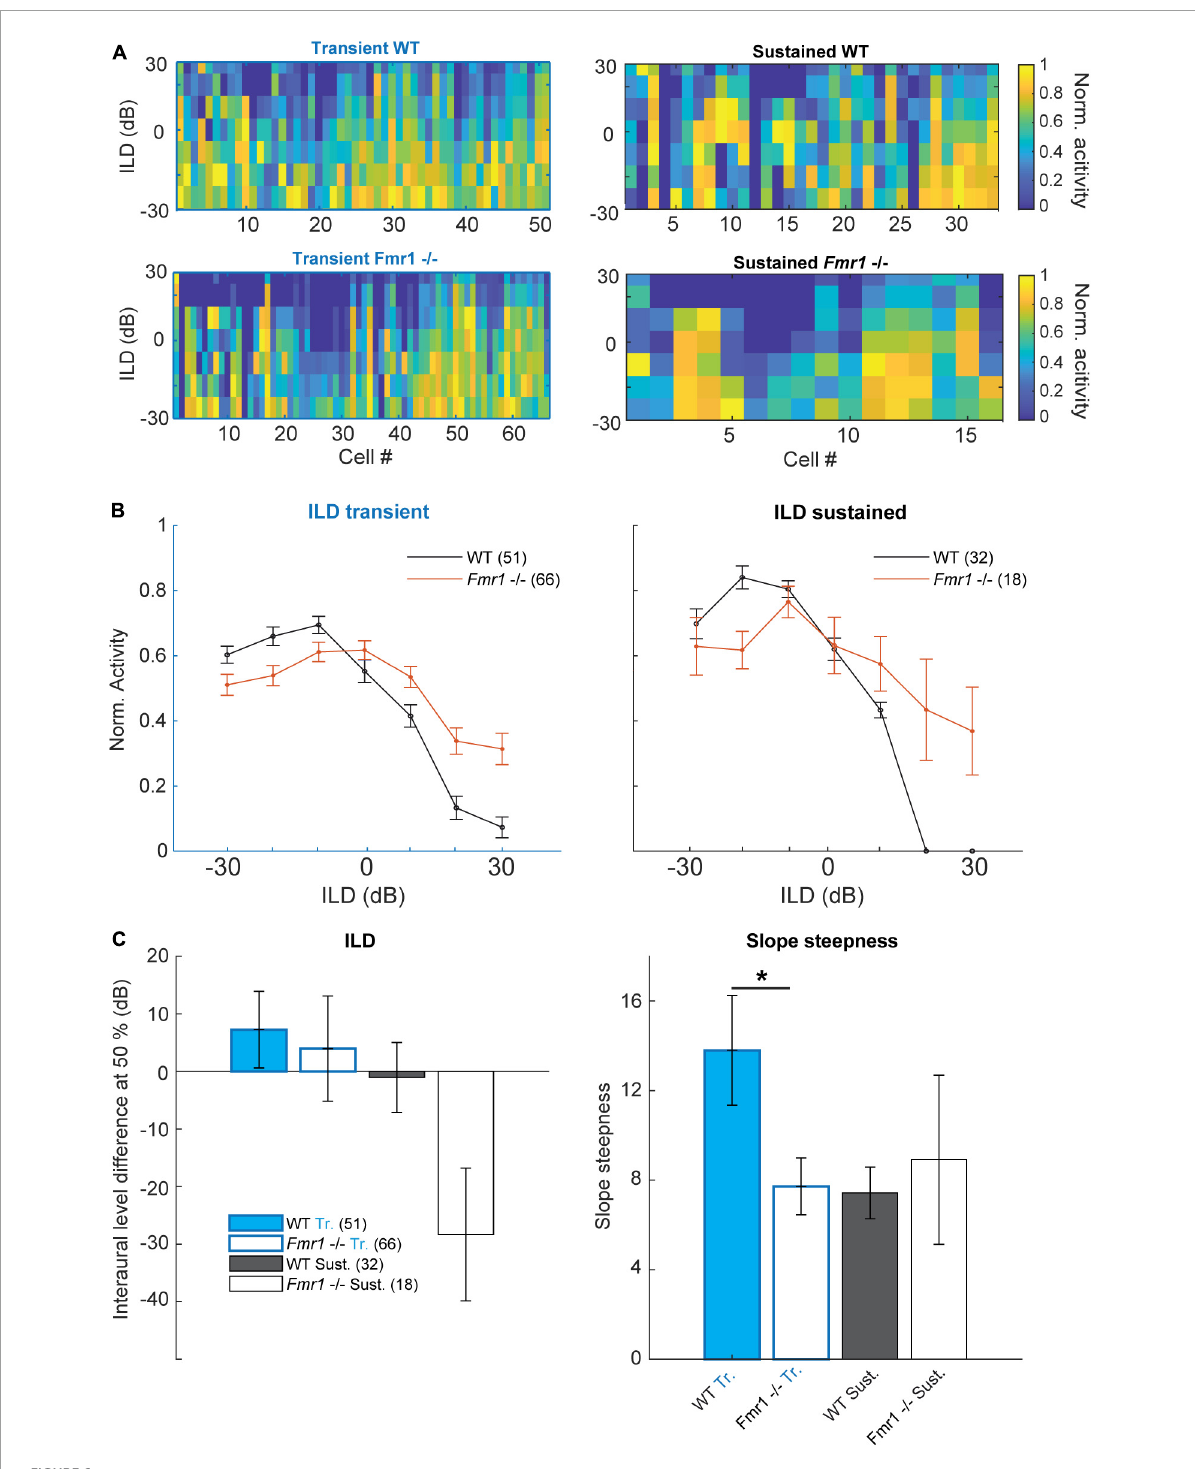
FIGURE6 Binaural integration of ILDs is impaired in the Fmr1 -/- mice. (A) Normalized spike rate per neuron for the different ILD conditions for: (above left) all WT transient neurons; (below left) all Fmr1 -/- transient neurons; (above right) all WT sustained neurons and (below right) all Fmr1 -/- sustained neurons. (B) (left) Averaged normalized ILD for all transient neurons WT and Fmr1 -/- ; (right) ILD for all sustained neurons WT and Fmr1 -/- . (C) Quantification of resp. (Left) averaged ILD as the half height of the corresponding fitted sigmoid; (right) for the slope steepness of resp. WT and Fmr1 -/-